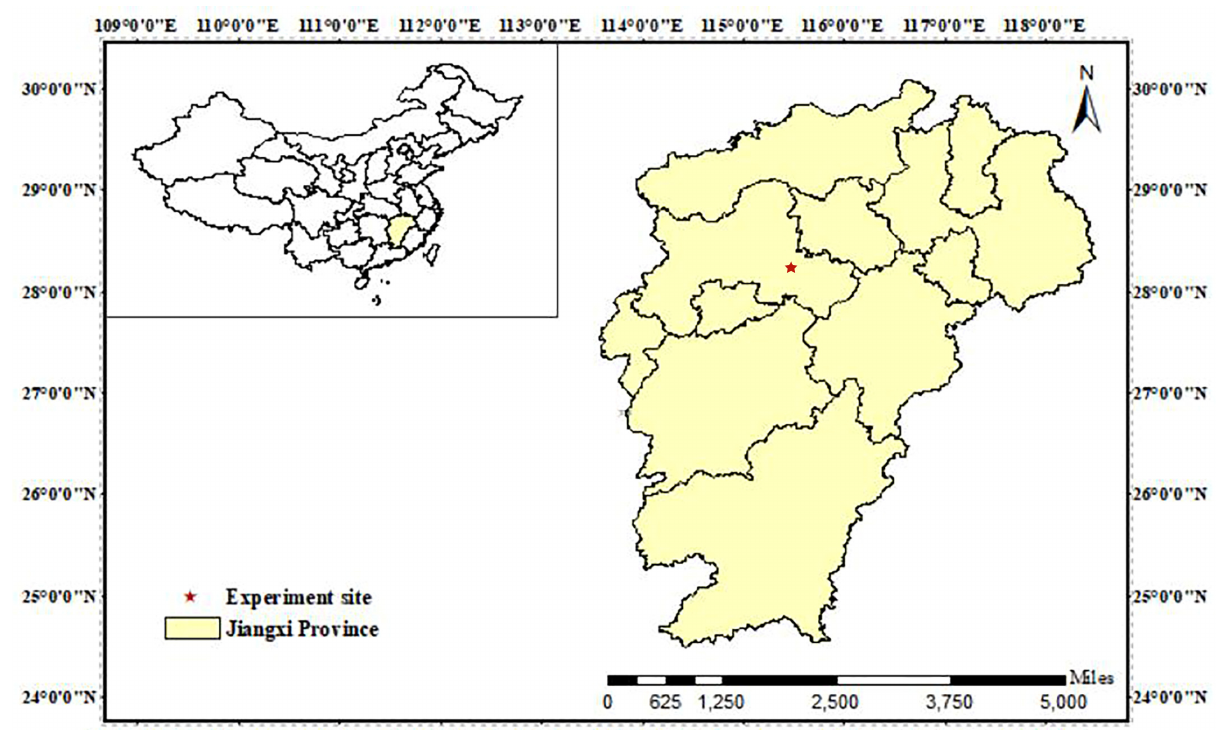
Figure 1. Location map of research site.